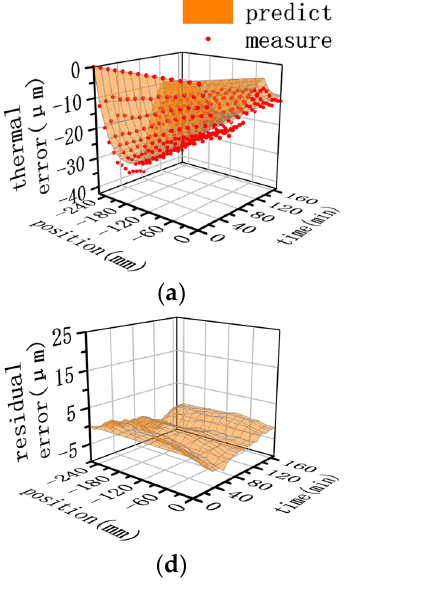
Figure 11. Z-axis error results. ( a ) Measured thermal error in Condition 1. ( b ) Measured thermal error in Condition 2. ( c ) Measured thermal error in Condition 3. ( d ) Residual error in Condition 1. ( e ) Residual error in Condition 2. ( f ) Residual error in Condition 3. Table 2. Simulation loading method of parameter identification.